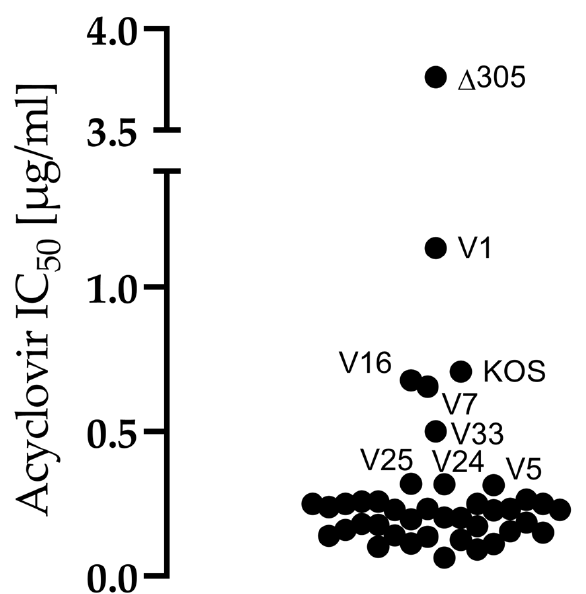
Figure 3. Sensitivities of the strains to acyclovir. Sensitivity to acyclovir (ACV) was measured with an assay conducted in Vero cells. For the assay, the cells were pre-treated with ACV (0.03125– 0.03128 µg/mL) and subsequently infected with 50 pfu of each virus in duplicates in a 96-well format. The read-out was at 72 hours post infection (hpi), when the formed virus plaques were quantified. Based on the amount of plaques in the control wells, half-maximal inhibitory values (IC 50 ) for ACV were determined separately for each strain. The limit of resistance was considered to be an IC 50 value of >1.90 µg/mL. The IC 50 value of each strain is plotted in the figure, and the names of the strains separating from the group are shown. The strain Δ305, which is a thymidine kinase deficient strain, was included as an ACV resistant control.